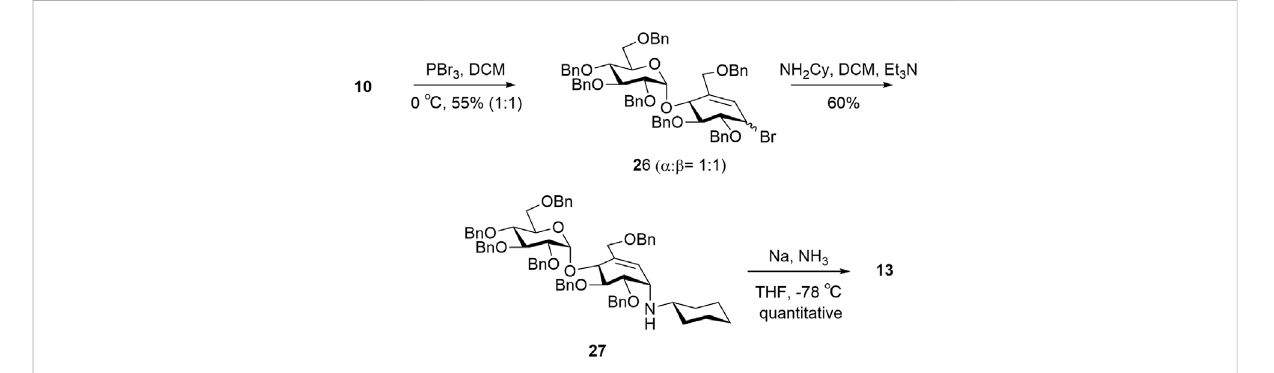
SCHEME 5 Synthesis of target 13